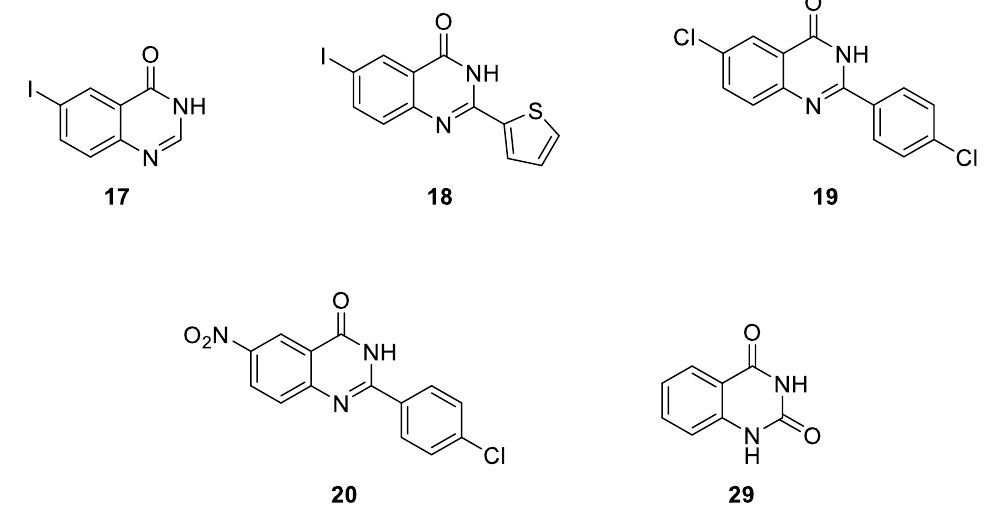
Figure 3 . Structures of compounds 17 - 20 and 29